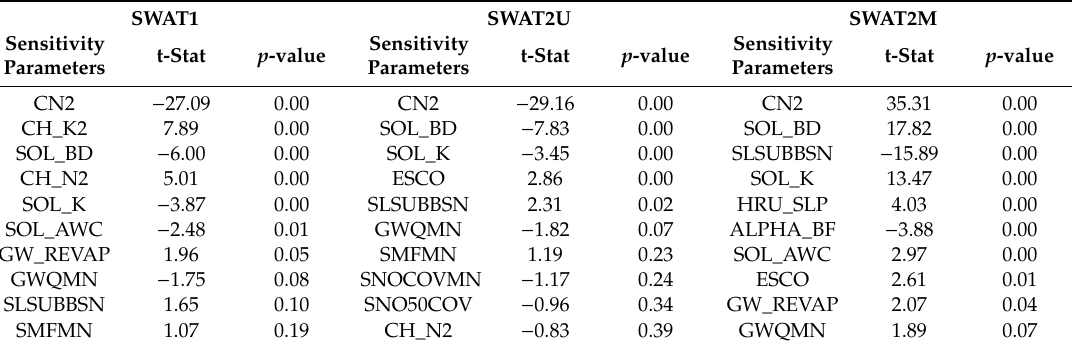
Table 2. Sensitivity parameters of the Soil and Water Assessment Tool (SWAT) models: SWAT1, SWAT2U and SWAT2M. SWAT1 SWAT2U SWAT2M Sensitivity t-Stat Parameters